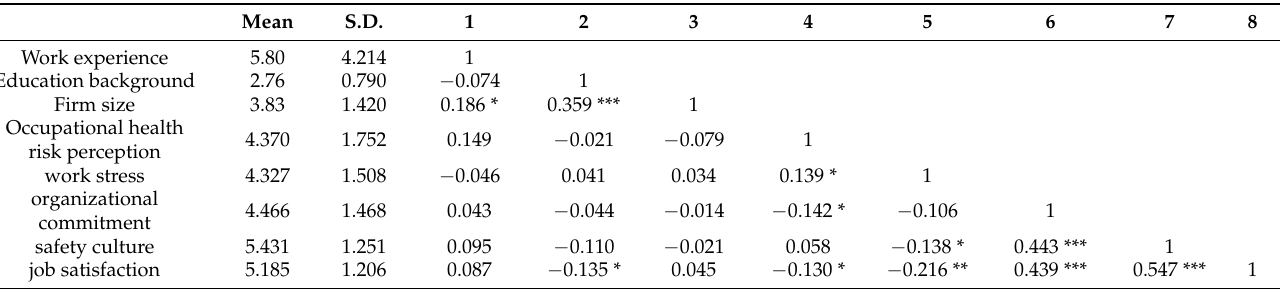
Table 2. Descriptive statistics and correlation matrix.